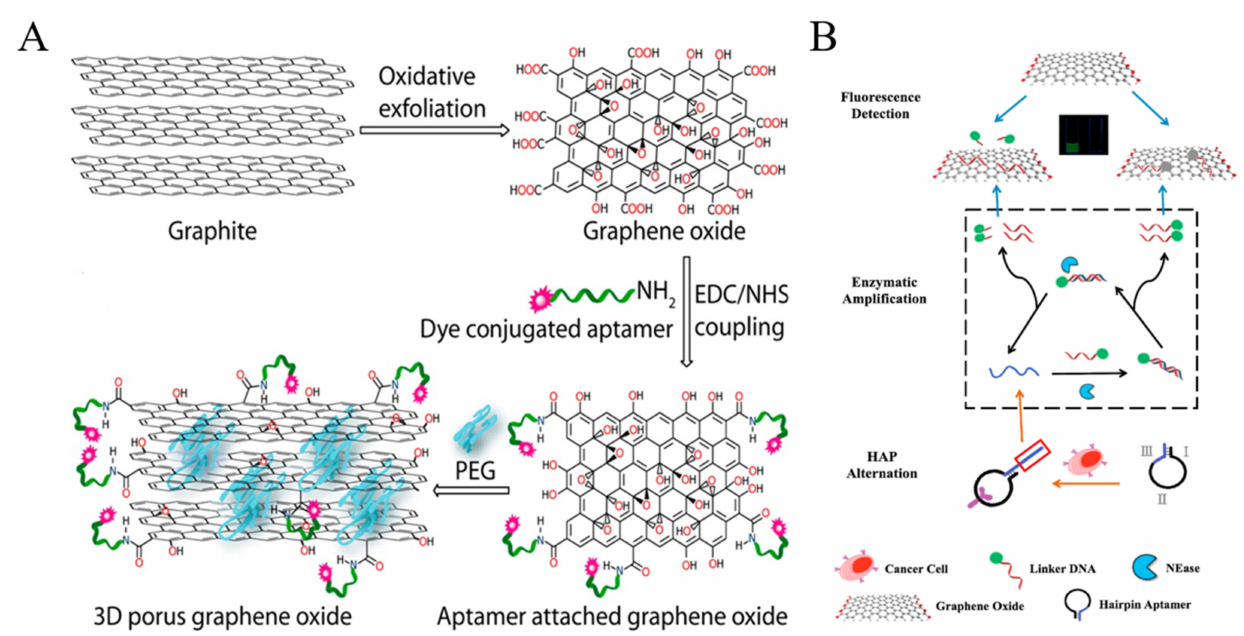
Figure 3. ( A ) Schematic representation showing the stepwise chemical formation of 3D graphene oxide [88]. Copyright 2015 American Chemical Society. ( B ) Schematic representation of a label-free and high-efficient GO-based aptasensor for the detection of low quantity cancer cells [91]. Copyright 2017 Elsevier